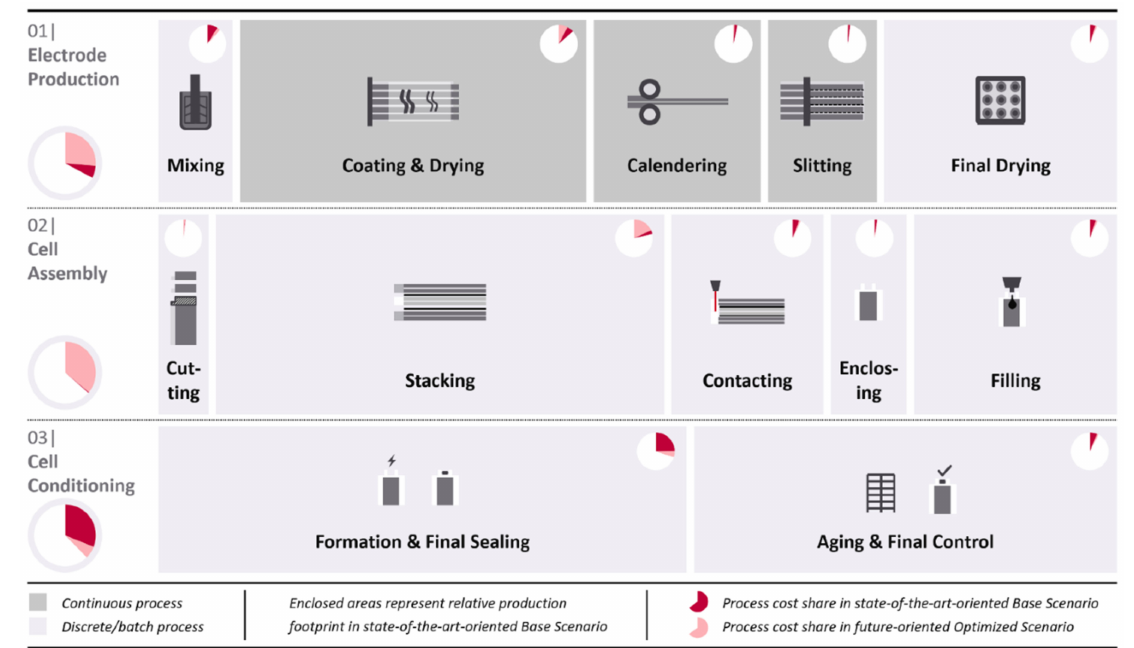
Figure 3. Manufacturing process steps of a lithium-ion pouch cells (CC BY Mauler et al.